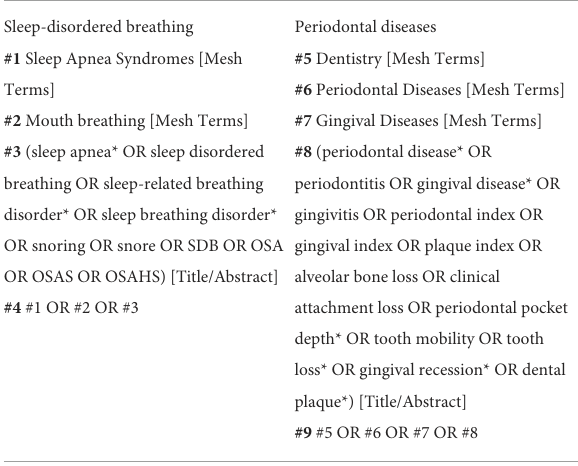
TABLE 1 Example search strategy for